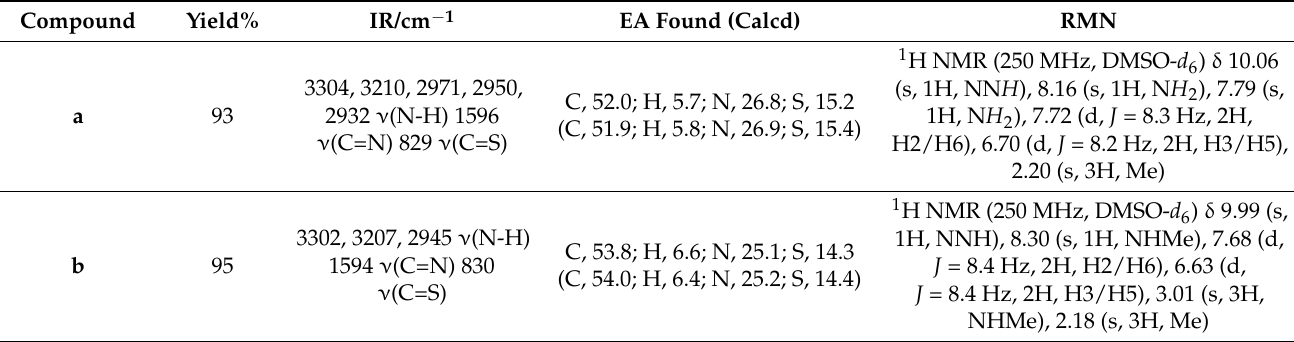
Table 4. Summary of the experimental Table 3. Summary of the main bands that experience changes due to the metalation.